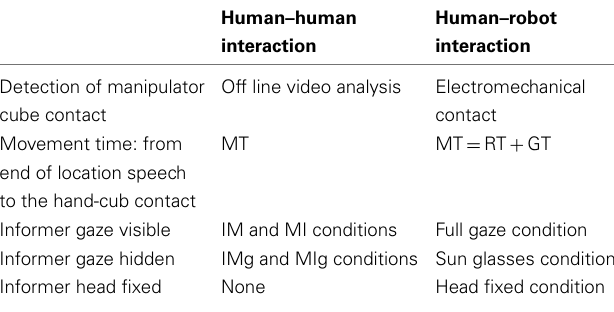
Table 2 | Comparison of contact detection systems, times measured, and conditions between the HHI and the